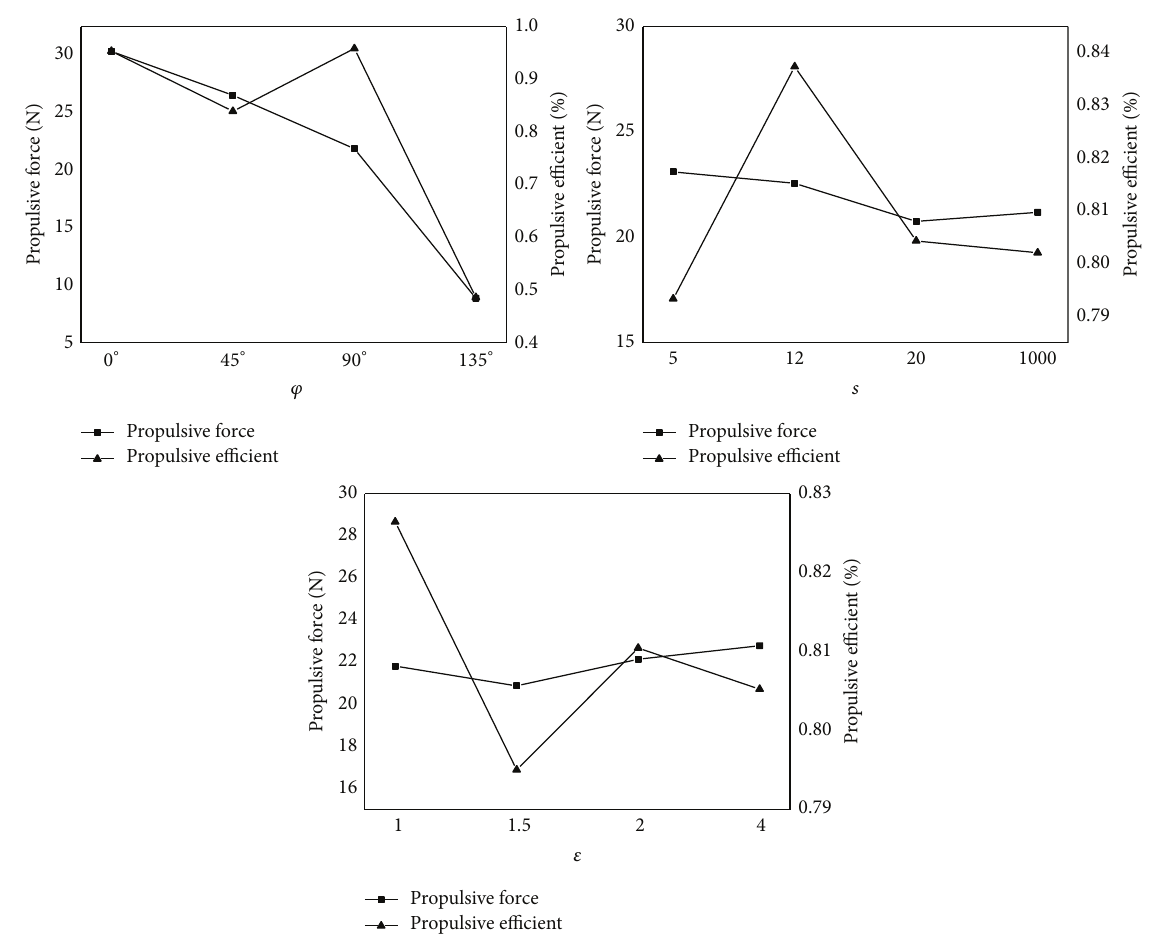
Figure 7: Influences on propulsive force and propulsive efficiency of different parameters.